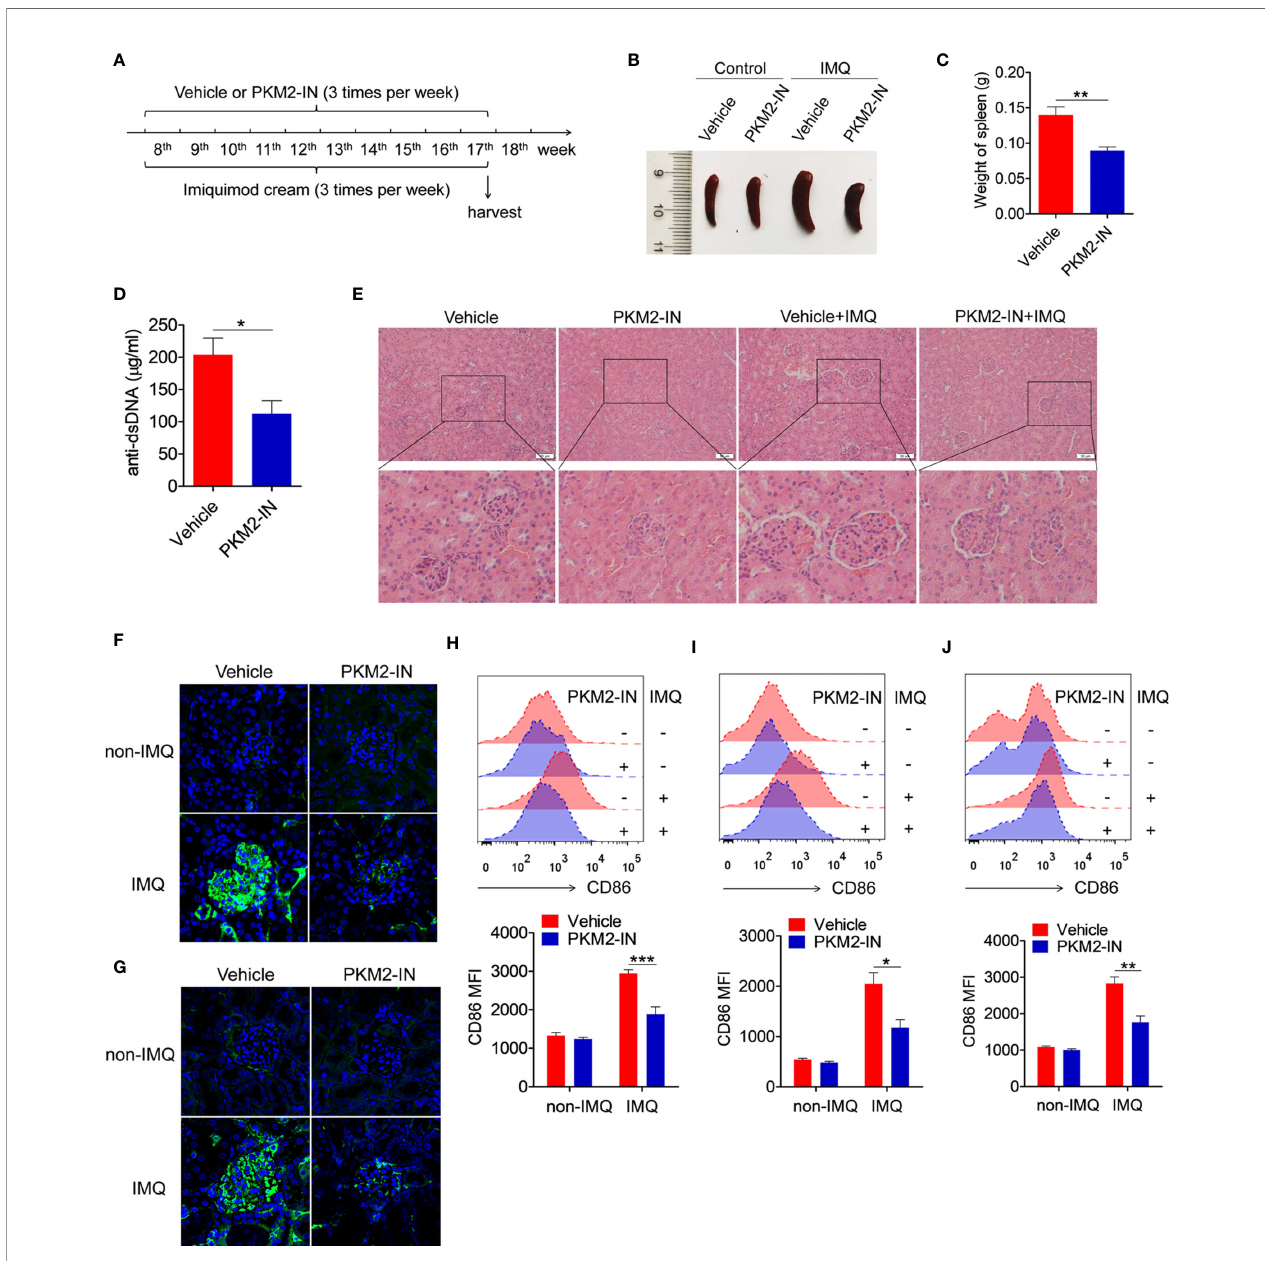
FIGURE 7 | Pharmaceutical inhibition of PKM2 relieves IMQ-induced lupus model. (A) Treatment schematic of PKM2-IN or vehicle injection to mice following epicutaneous application of imiquimod. (B) Representative images of marked splenomegaly in all groups of mice. (C) Weight of spleens in PKM2-IN- or vehicle-treated IMQ-mice. (D) ELISA analysis of the anti-dsDNA antibody in serum. (E) H&E staining of the kidney sections from all groups of mice. (F, G) Immuno fl uorescence staining to detect IgG (F) and IgM (G) deposit in the kidney sections. (H – J) Flow cytometric analysis of CD86 expression on splenic macrophages (H) , DCs (I) and B cells (J) in allgroups ofmice. The data areshownas the means ± SEM (n=7 mice/group) andare representative ofthree independent experiments. * p < 0.05, ** p < 0.01, *** p < 0.001, as determined byANOVA tests or t